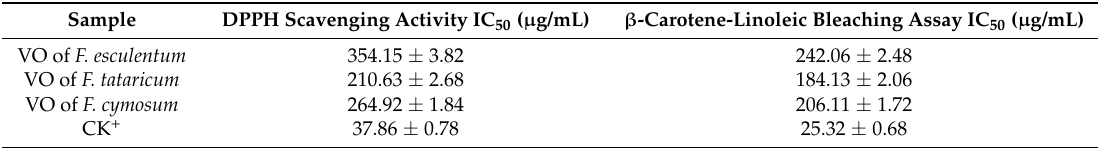
Figure 1. DPPH scavenging activity of the flower volatile oils of F. esculentum , F. tataricum and F. cymosum. Table 4. Antioxidant activity of the volatile oils of three buckwheat